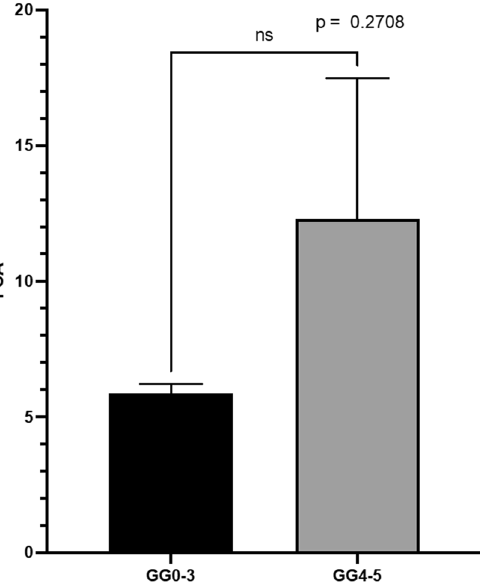
Figure 7. Mean PSA for the GG 0–3 group (left black bar) and the GG 4–5 group (right gray bar). The Y-axis is the linear combination of the measurements (Mean, N = 96, median of 3 replicates, error bars